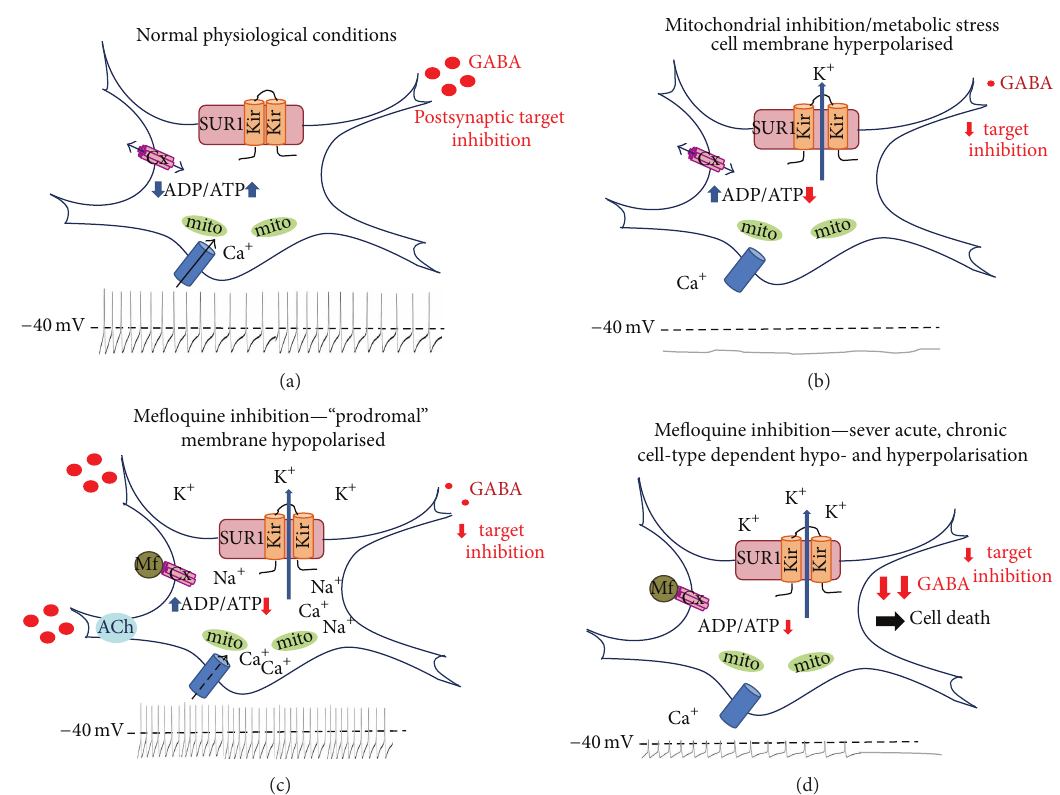
Figure 1: K ATP channels found within the cell membrane of both pre- and postsynaptic neurons of the substantia nigra (SNr) and ventral tegu- mental area (VTA), as well as other brain regions. In the SNr and VTA, the majority of K ATP neurons are dopaminergic and exert GABAergic inhibition on their postsynaptic targets. (a) Within these cells, under normal physiological conditions, K ATP channels are closed and ligand- gated calcium channels are free to open allowing hypopolarisation of the cell membrane and tonic excitation. Connexin channels (Cx) are also open allowing for exchange of ions, metabolites, and second messengers to enable appropriate electrical coupling. (b) Under conditions of metabolic stress or hypoxia, ATP depletion causes K ATP channels to open and Ca + channels to close, hyperpolarising the cell membrane and conferring neuroprotective proprieties by inhibiting neuronal excitation. Inhibition of target cells is diminished due to reduction in GABA release, stimulating hypopolarisation in postsynaptic targets. Connexin channels are hypothesised to remain open under these conditions. (c) Inthepresenceoflowconcentrationsofmefloquine,K-ATPchannelsareinhibitedandremainopenintheabsenceofmetabolicstress,causing potassium efflux from the cell and increased transport of sodium into the cell through this open cation pore. This sodium influx causes an initial hypopolarisation, increasing tonic firing and initially enhancing presynaptic GABA release. Increased activity of Na + K + -ATPase trans- membrane channels increases metabolic stress, ensuring that K ATP channels remain open. GABA release is, initially, further enhanced by inhi- bitionofcholinesterase(ChE)whichresultsinaccumulationofendogenousacetylcholine(ACh)inthepresynapticterminal.Continuedexpo- sure is likely to result in intracellular ATP depletion, and finally GABA depression, resulting in a loss of postsynaptic inhibition. In addition, mefloquine (Mf) blocks connexin channel transport, further dysregulating intra- and intercellular excitability, giving rise to additional neu- ropsychiatric symptoms such as focal cortical or limbic seizures. (d) Exposure to high levels of mefloquine, or continued long-term exposure, would result in complete inhibition of K ATP channel closure, continued connexin channel blockade, and permanent dysregulation of postsy- naptic inhibition by presynaptic GABAergic inhibition as well as exerting significant neuronal metabolic stress, finally resulting in metabolic